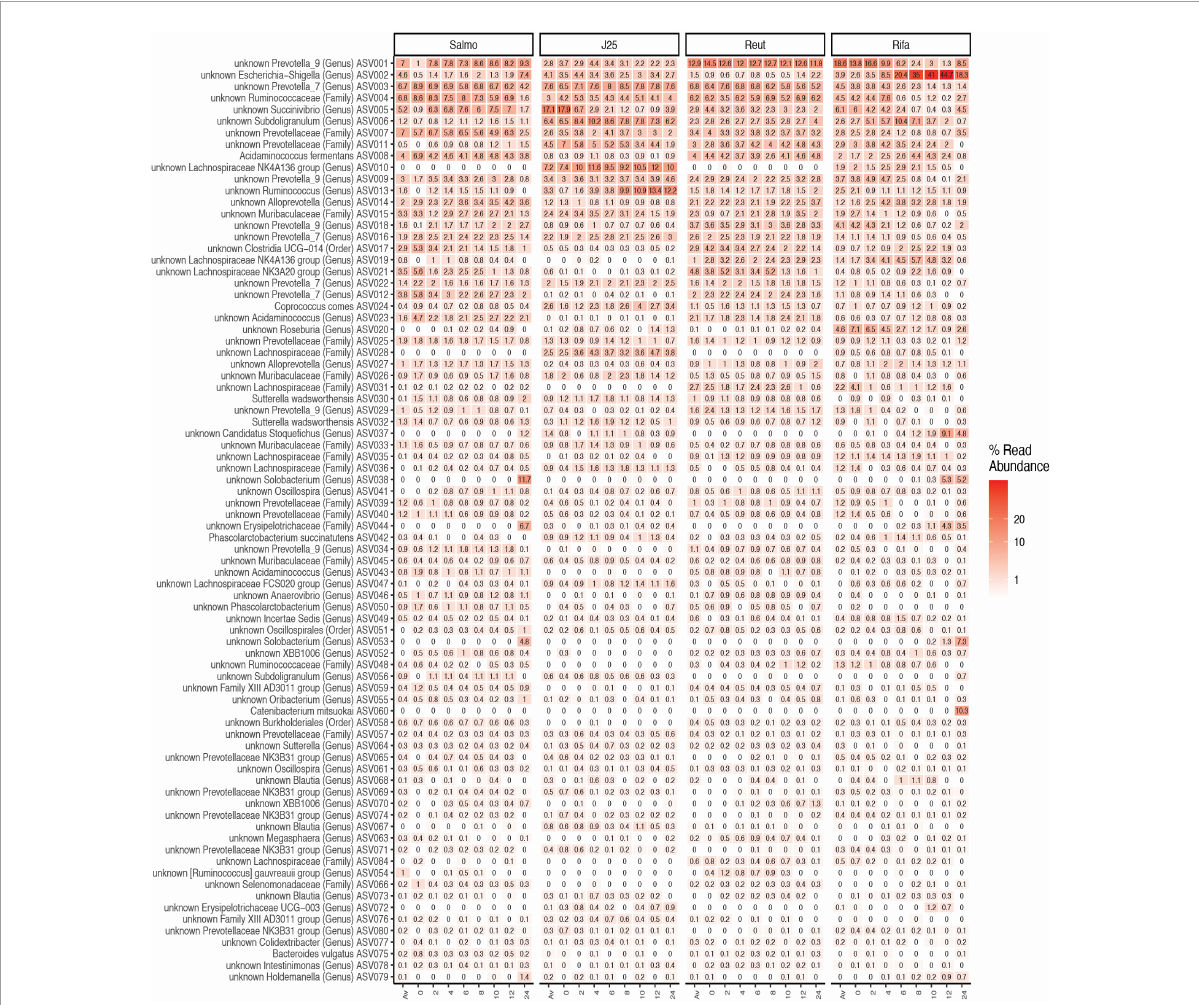
FIGURE5 Microbial community structure of porcine intestinal microbiota after inoculation of Salmonella Newport alone (Salmo) and in combination with MccJ25 (J25), reuterin (Reut) or rifampicin (Rifa) on the porcine intestinal microbiota in vitro . Microbial composition measured by 16S rRNA gene amplicon sequencing at different days: Av (before treatment), 0, 2, 4, 6, 8, 10, 12, 24) represented by relative abundance (%) at the highest-level taxonomy. Values are the average of two biological replicates from two independent fermentations. The most abundant 80 ASVs shared in all treatments are